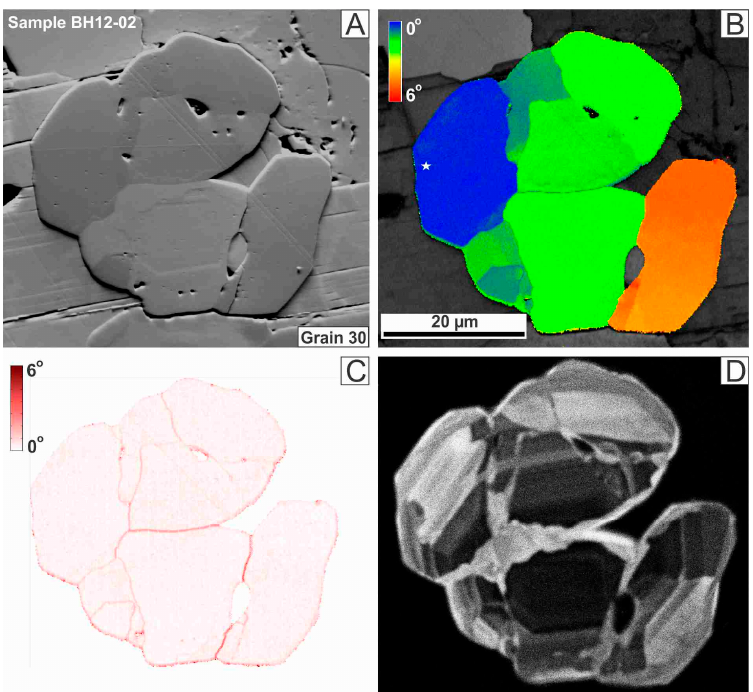
Figure 7. Data on the grain 30, sample BH12-02. ( A ) Orientation contrast image. ( B ) Cumulative misorientation EBSD map, showing the orientation of every data point with respect to a user-selected reference point (white star). Misorientation varies from 0 (blue) to 6° (red). ( C ) Local misorientation EBSD map, showing misorientation of every pixel with respect to its neighbors. Local misorientation does not exceed 6°. The map shows low-angle boundaries that separate strain-free subgrains. ( D ) Panchromatic CL image.